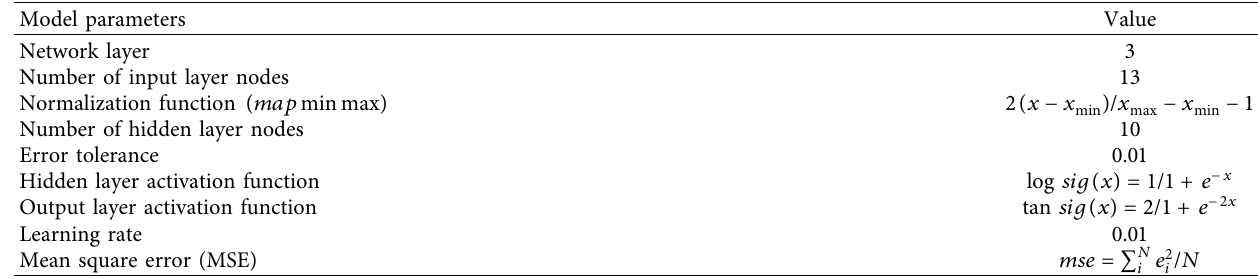
Table 6: Model parameters and